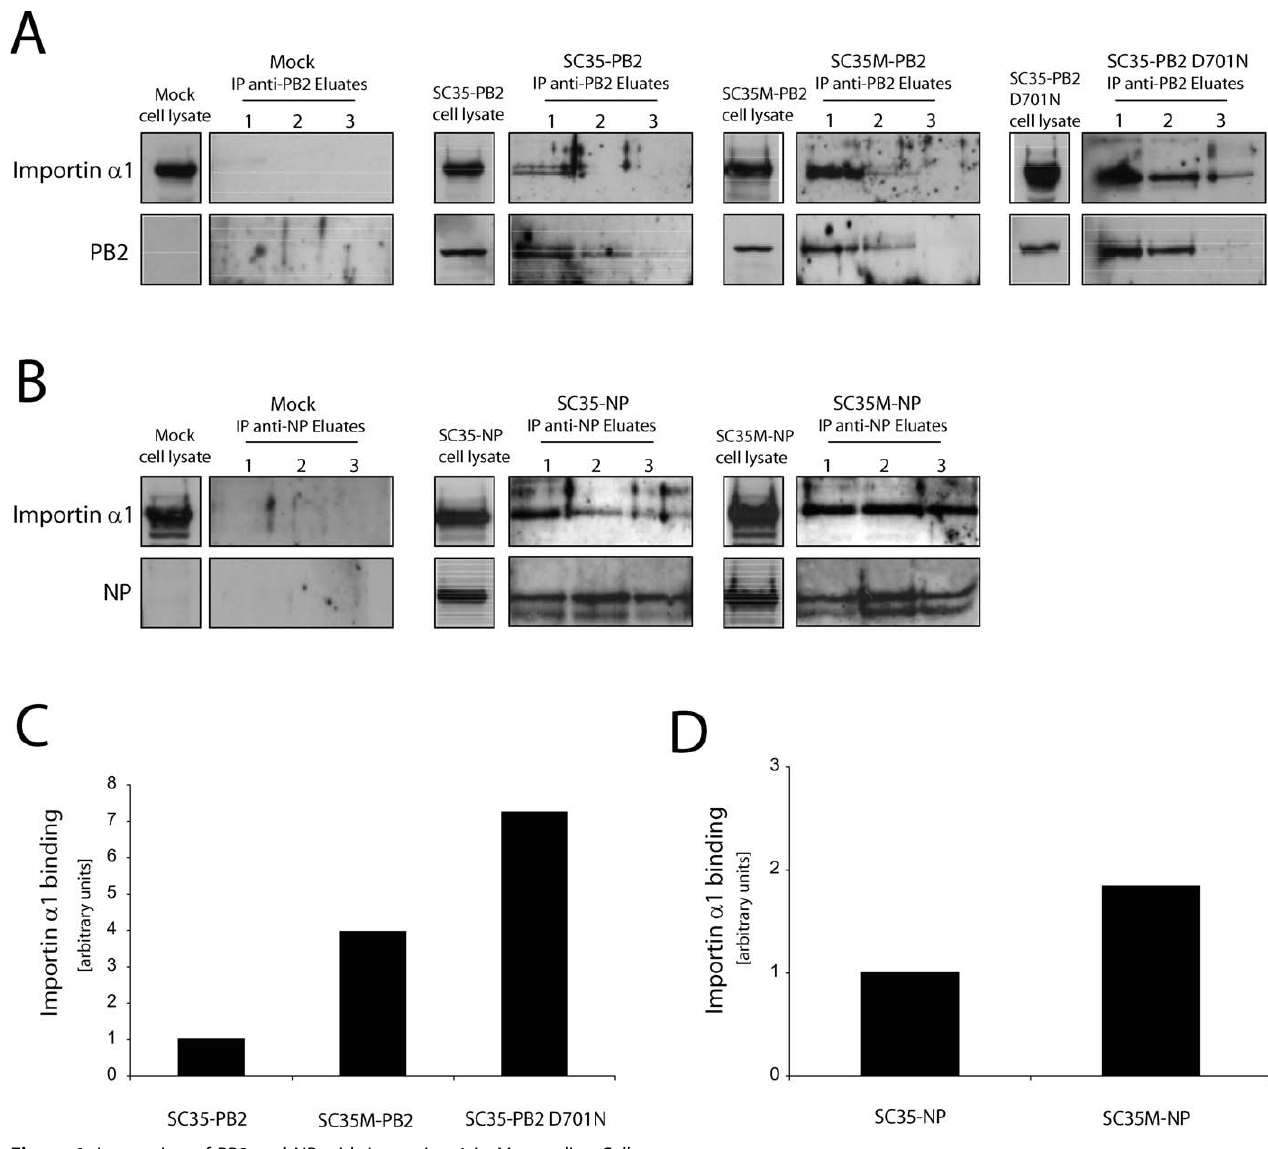
Figure 1. Interaction of PB2 and NP with Importin a 1 in Mammalian Cells 293T cells were transfected with plasmids encoding SC35-PB2 (30 l g), SC35M-PB2 (30 l g), and SC35-PB2 D701N (30 l g) (A) and SC35-NP (10 l g) and SC35M-NP (10 l g) (B) proteins. As a control, non-transfected cells were used (Mock). 48 h after transfection cells were harvested and immunoprecipitated using the respective PB2 or NP antibody. Precipitated eluates (1–3) and non-precipitated whole cell lysates of transfected cells were subjected to SDS gel electrophoresis, and PB2, NP, and importin a 1 were detected by Western blot analysis. In (B) two NP bands can be seen of which the minor one most likely represents a cleavage product [39]. The total amount of importin a 1 bound in all three eluates to PB2 (C) and NP (D) was quantitated using Image J software (http://rsb.info.nih.gov/ij/). An arbitrary unit is the amount of importin a 1 bound to SC35 PB2 and SC35 NP, respectively.